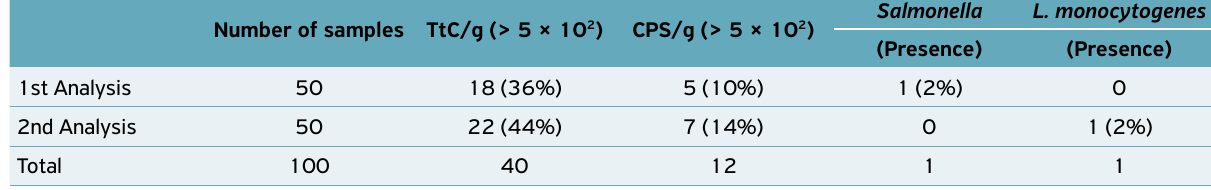
TtC: coliforms at 45ºC; CPS: coagulase-positive staphylococci